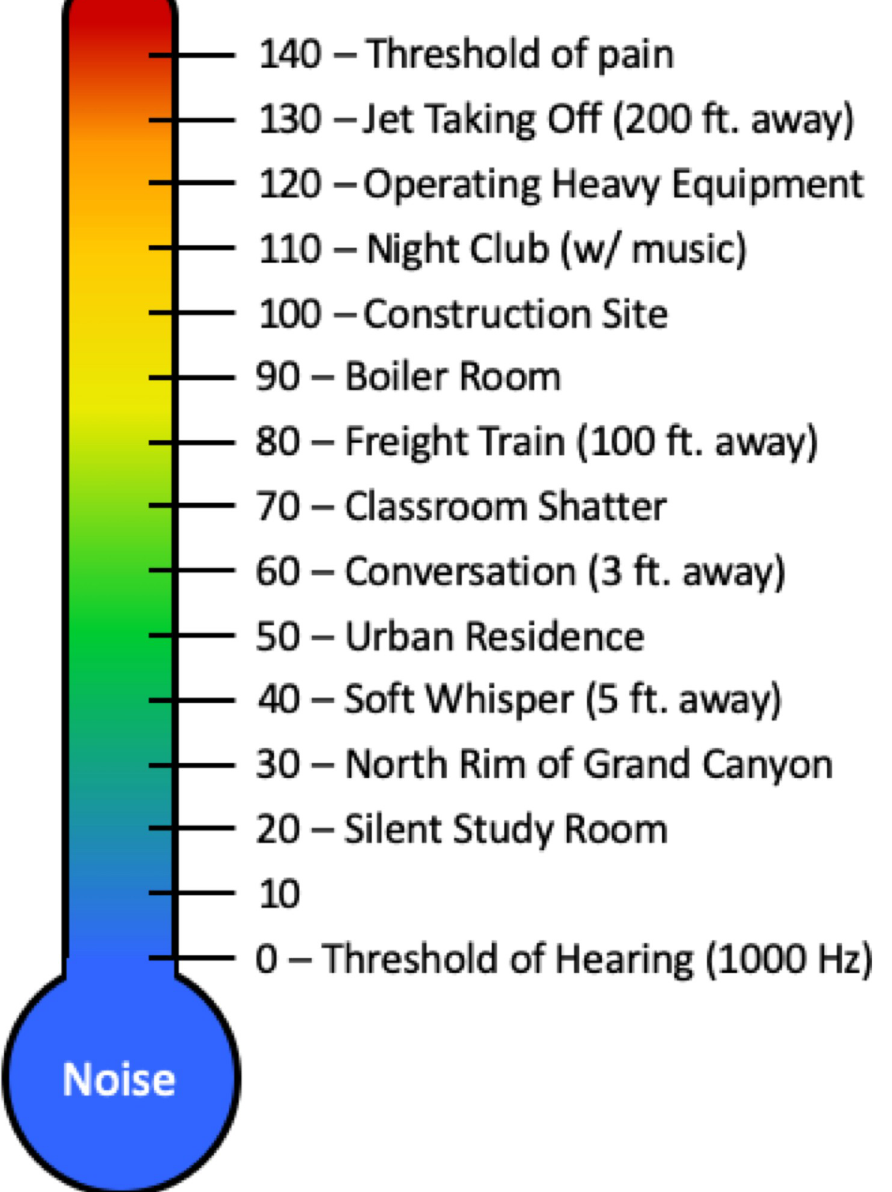
Fig 5. Typical sound levels on the dBA scale. Figure adapted from OSHA Technical Manual [25].